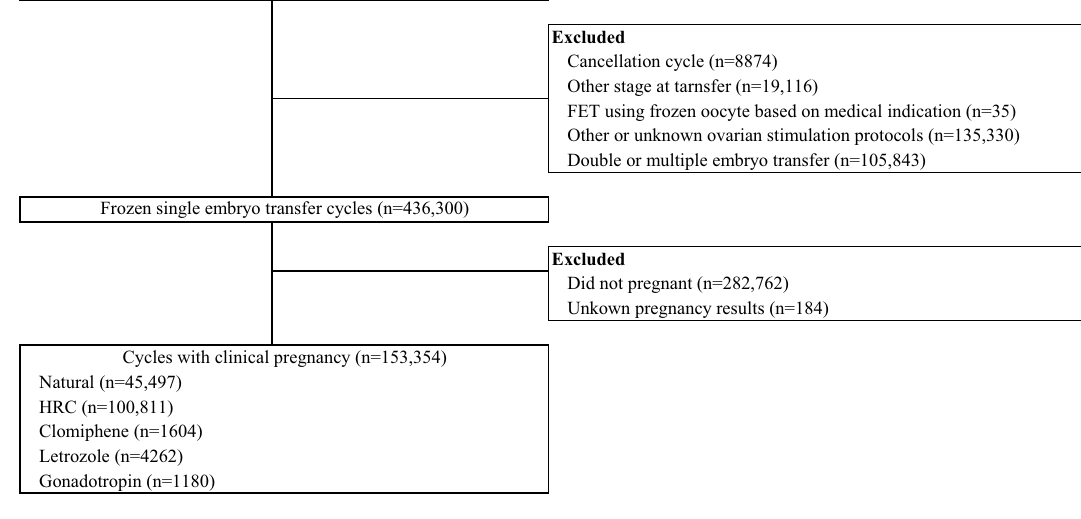
Figure 1. Flow diagram of cohort